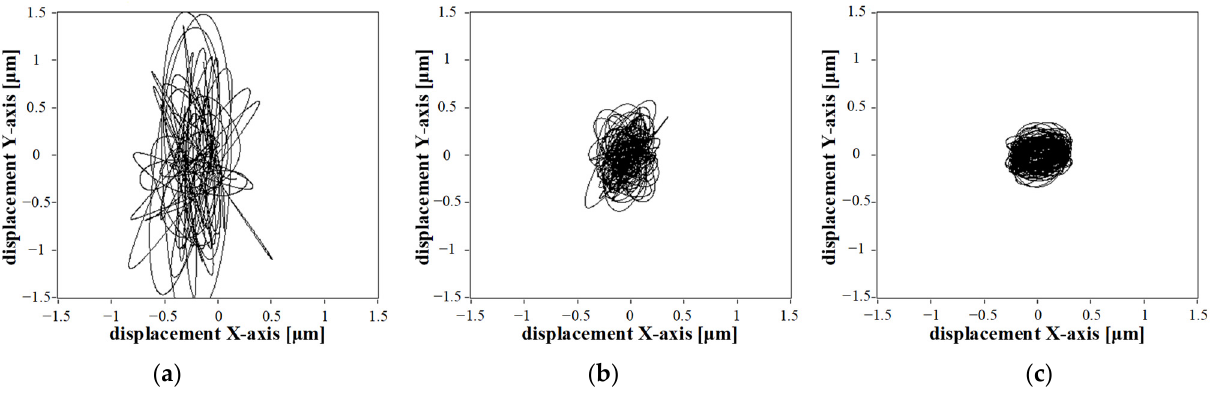
Figure 13. Sample orbits recorded for an unbalance mass of m 4 = 2.05 g and for a speed of 300 rpm ( a ), 600 rpm ( b ) and 750 rpm ( c ). 600 rpm ( b ) and 750 rpm ( c ).